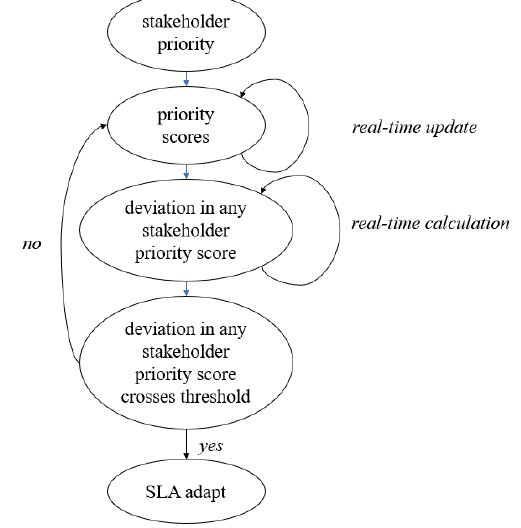
Figure 3. SLA Assignment and Management